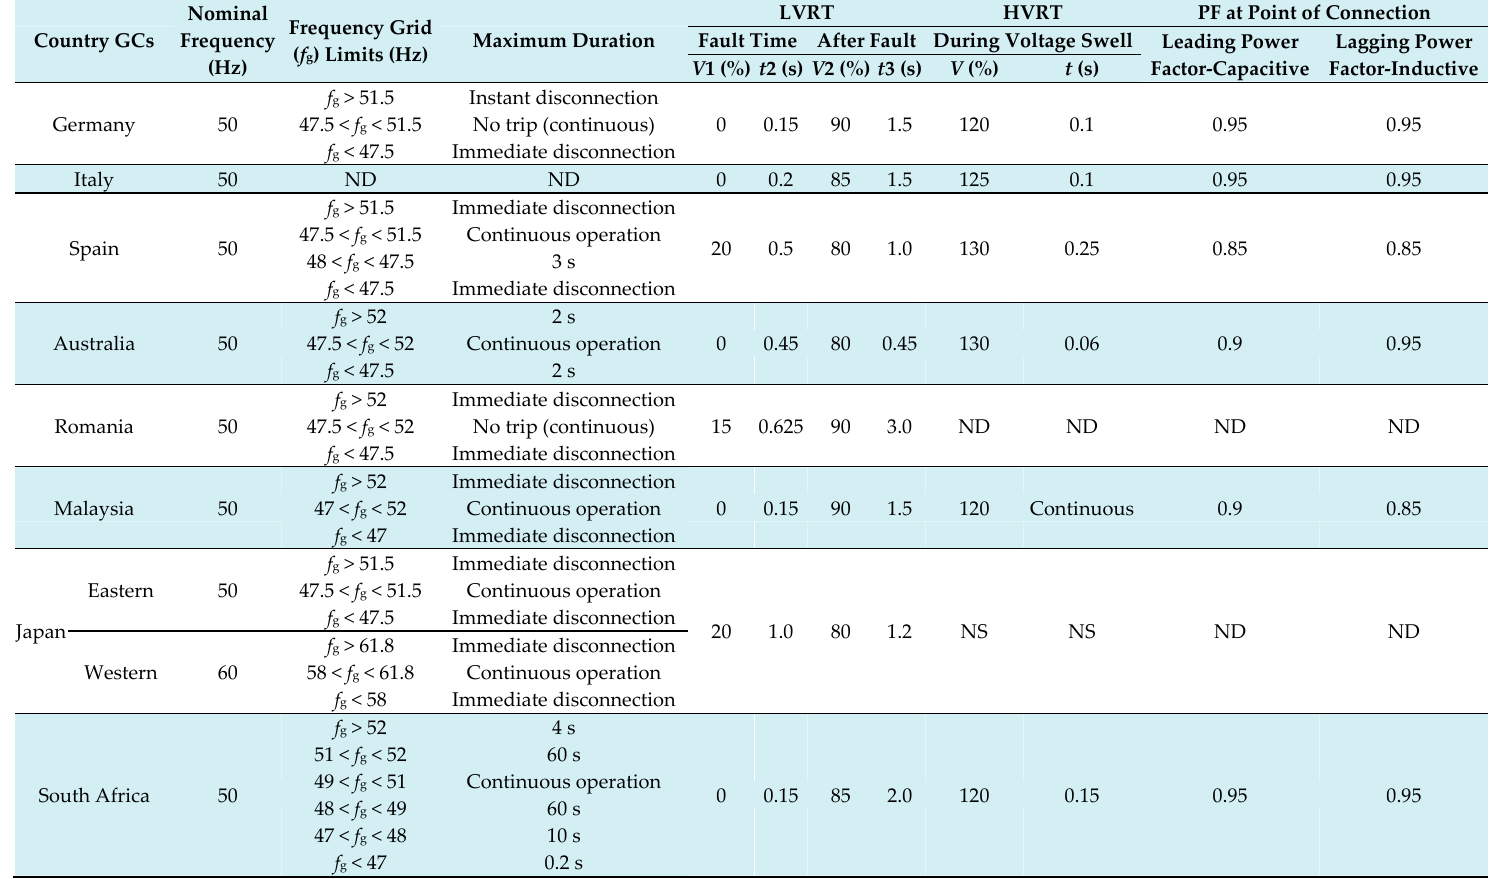
Table 1. Required nominal frequency, frequency limits, low-voltage ride through (LVRT), high-voltage ride through (HVRT), and power factor (PF) for point-of-common- coupling (PCC) grid codes ( GCs) in some countries. ND: not